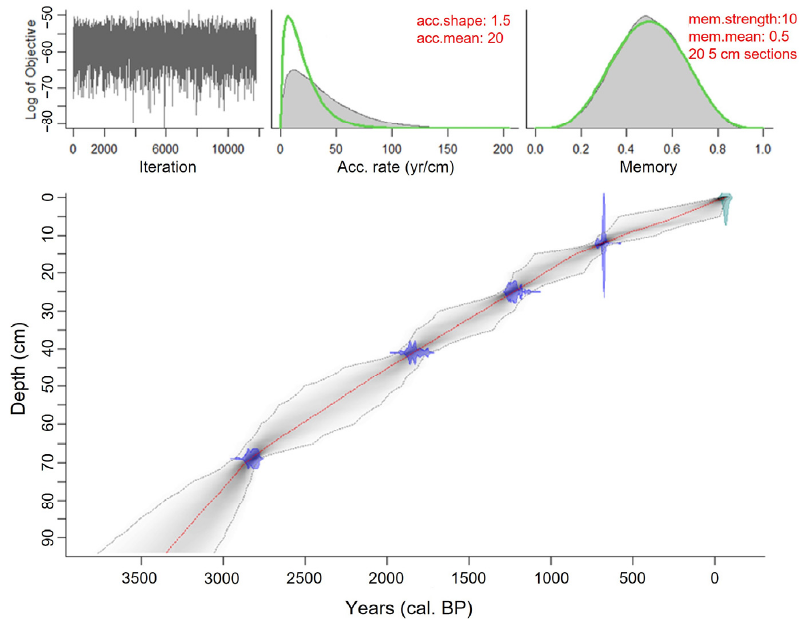
Figure 5. Bayesian age-depth model of Lake Evilik. Top panels represent MCMC iterations representing model stability, prior (green lines) and posterior (grey) distributions for accumulation rate (middle panel) and model memory properties (right panel). The calibrated ages of the 4 dated samples ( 14 C) and their probability distribution are shown in blue. The grey area bounded by the dashed lines represents the age model with the 2 σ (95%) con fi dence interval, and the red line indicates the weighted mean age (the most probable date).